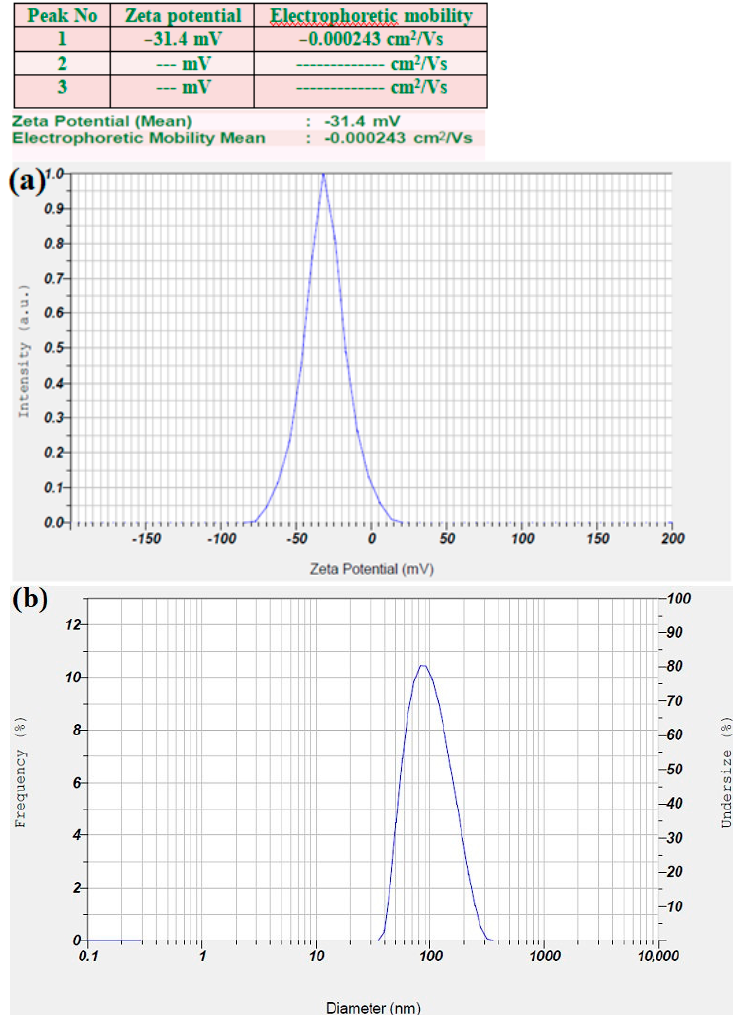
Figure 8. ( a ) Zeta potential analysis graph and ( b ) dynamic light scattering analysis of biosynthesized LnFb-AgNPs from L. nepetifolia flower bud extract.